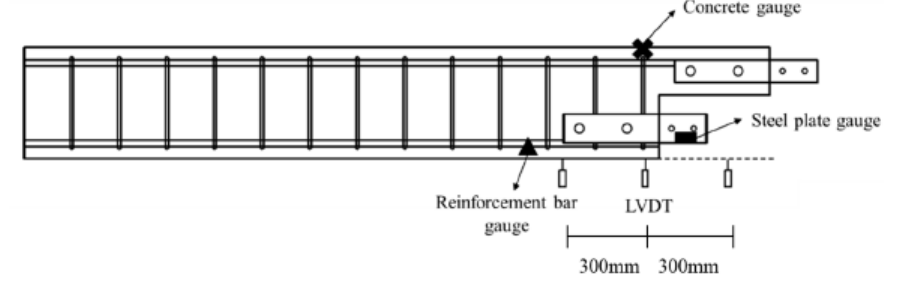
Figure 10. Position and naming of gauges. Table 2. Instruments installed on